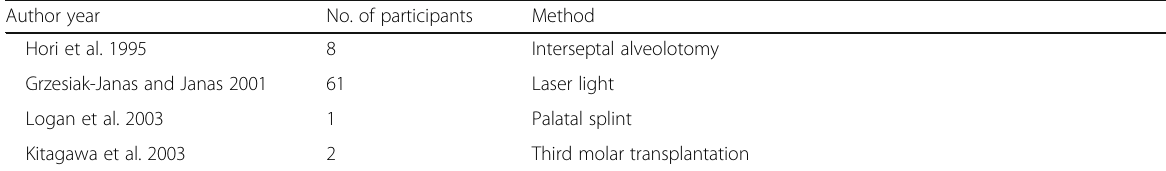
Table 1 Studies on surgical techniques for closure OAFs